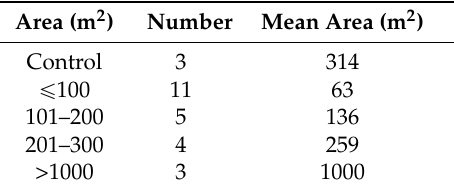
Table 1. Gap and control plot